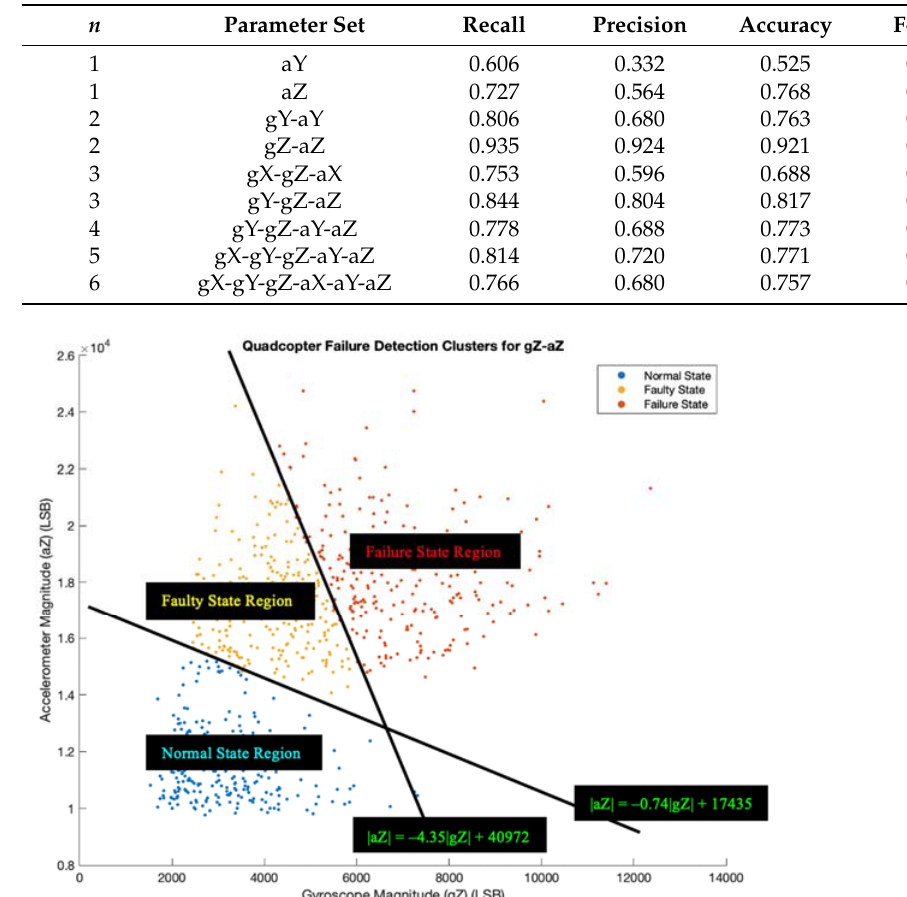
Figure 11. Chosen QFDC Plot with Boundary Conditions.